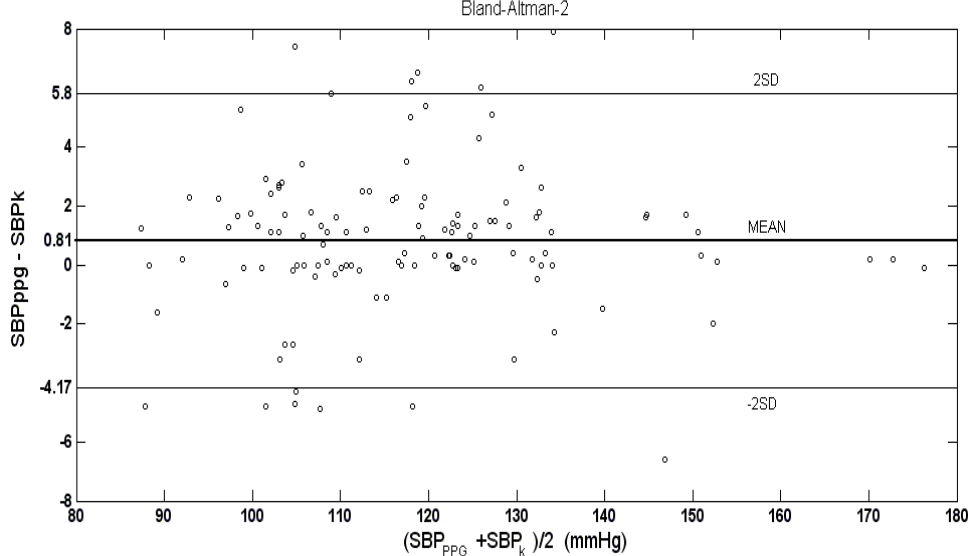
Figure 6. Bland-Altman plot of the difference between SBP values measured by PPG and by Korotkoff sounds (SBP -SBP ) as a function of their mean. The mean difference was PPG K 0.81 mmHg and the 2SD values were ±4.98 mmHg. More examinations showed positive SBP -SBP than negative SBP -SBP . PPG K PPG K